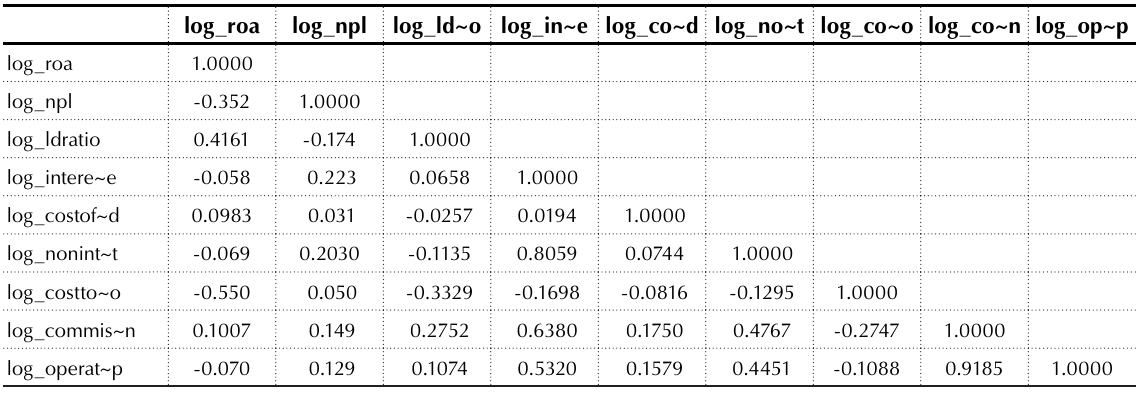
Table 7. Correlation matrix model (ROA)